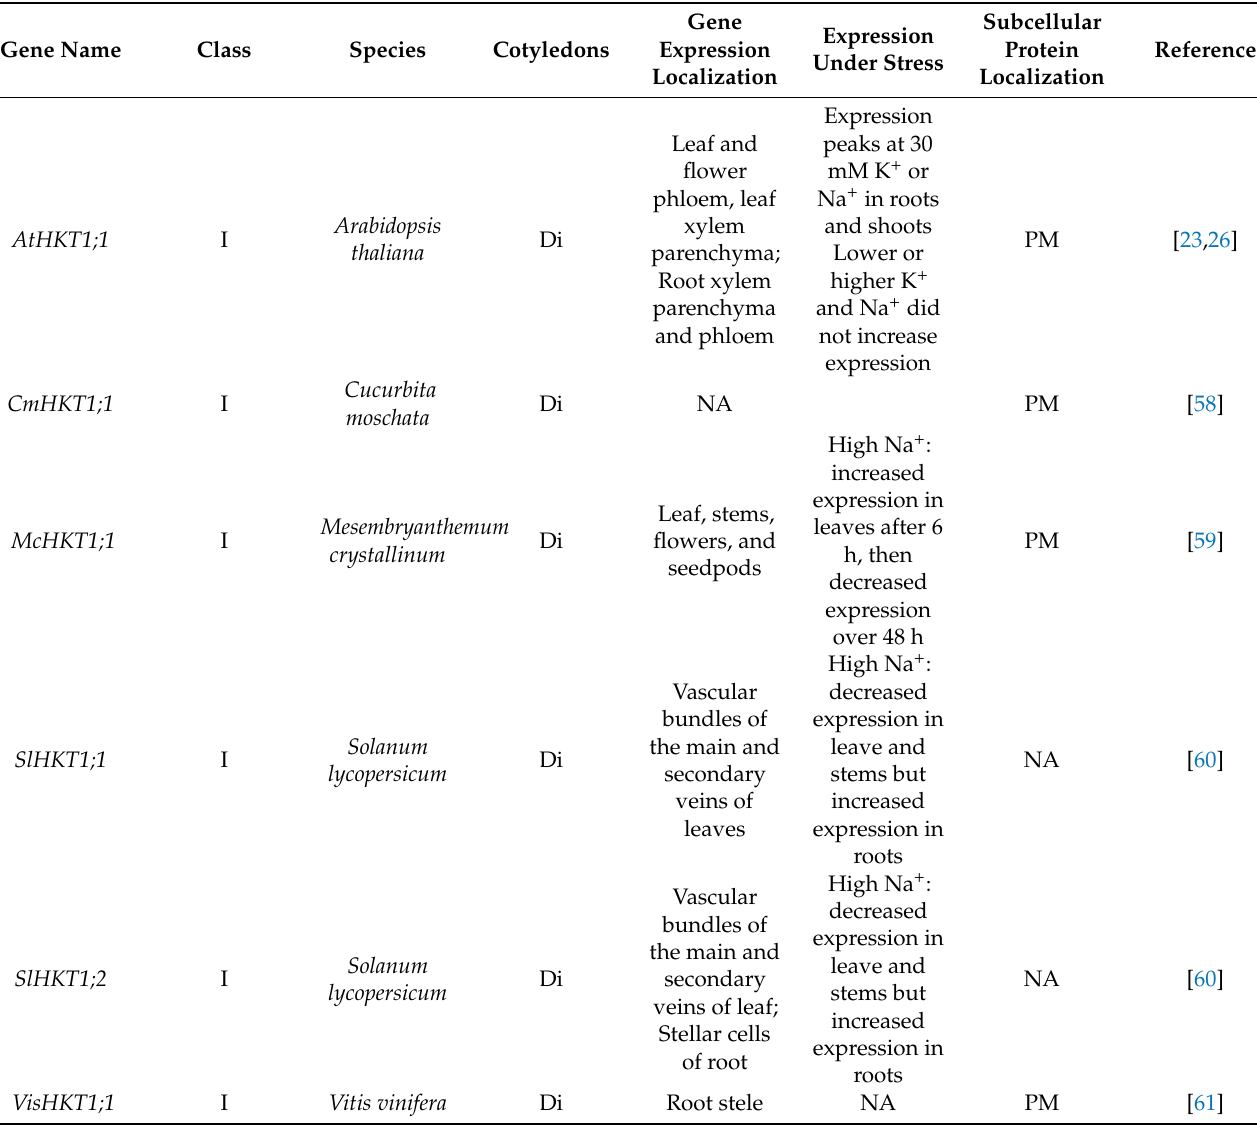
Table 1. Gene expression and subcellular protein localization. Di—dicotyledons; Mono—monocotyledons; PM—plasma